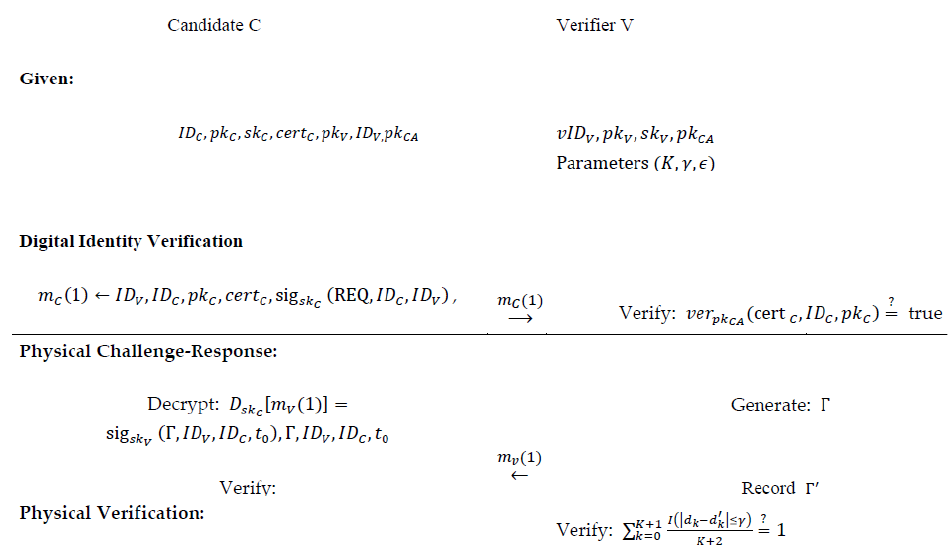
Figure 4. The CAVVPM protocol.